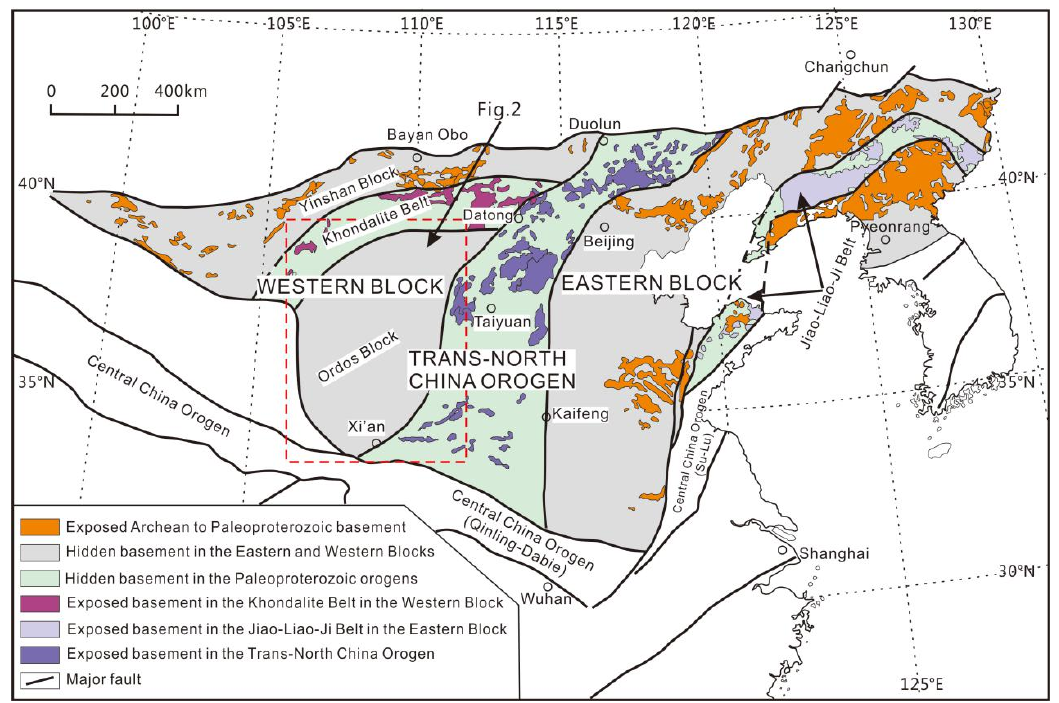
Figure 1. Tectonic map of the North China Craton showing Paleoproterozoic orogenic belts [6] (modified after Zhao et al., 2005). see Ordos Basin in Figure 2.